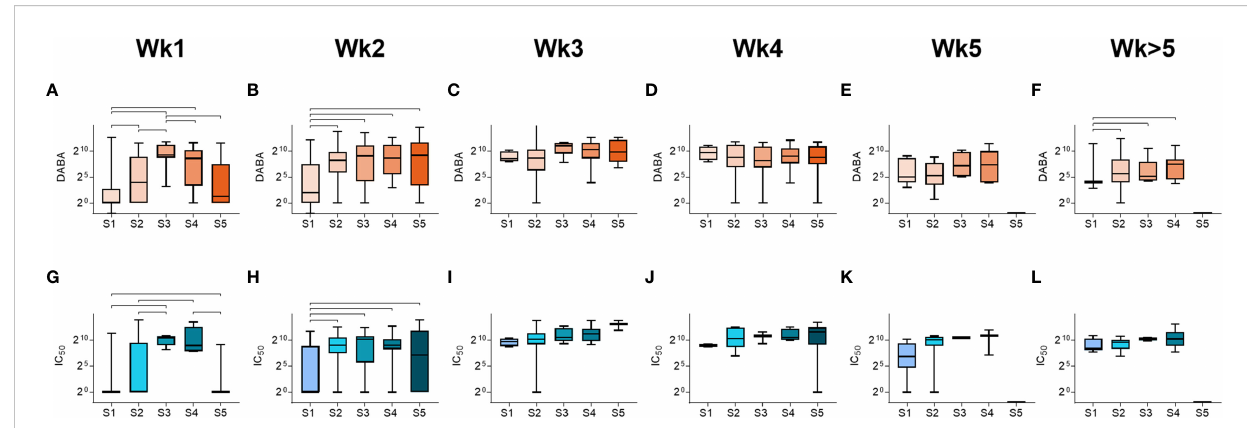
FIGURE 3 Antibody responses by severity groupings and time following disease onset. (A-F) Total anti-RBD titres grouped by severity (S1-S5), measured from samples taken at (A) week 1, (B) week 2, (C) week 3, (D) week 4, (E) week 5 and (F) past week 5 post-symptom onset. (G-L) Neutralising antibody (IC 50 ) titres grouped by severity (S1-S5), measured from samples taken at (G) week 1, (H) week 2, (I) week 3, (J) week 4, (K) week 5 and (L) past week 5 post-symptom onset.Statistically signi fi cant differences (non-parametric ANOVA (Kruskal-Wallis test) are indicated by horizontal lines above the